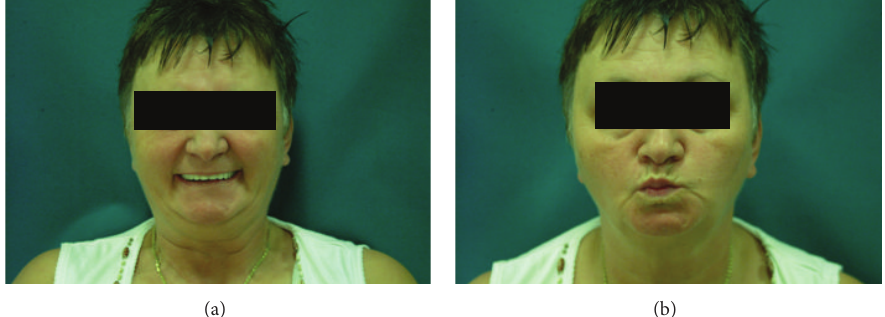
Figure 2: Thirty-six days following stapes surgery: the facial nerve function is intact, teeth showing (a) and lip rounding (b).